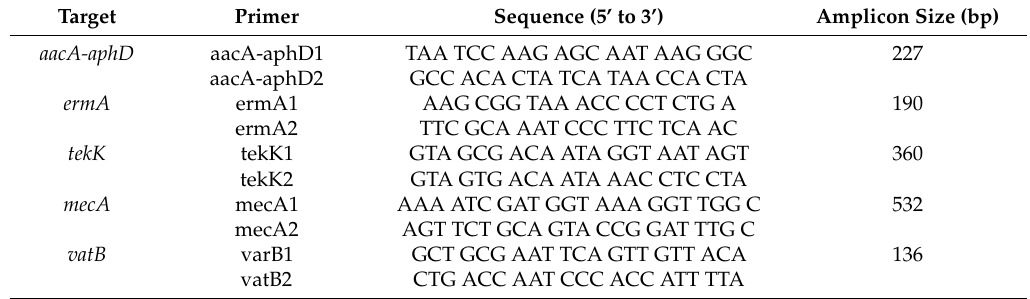
Table 3. The primers used in the PCR reaction and size of the